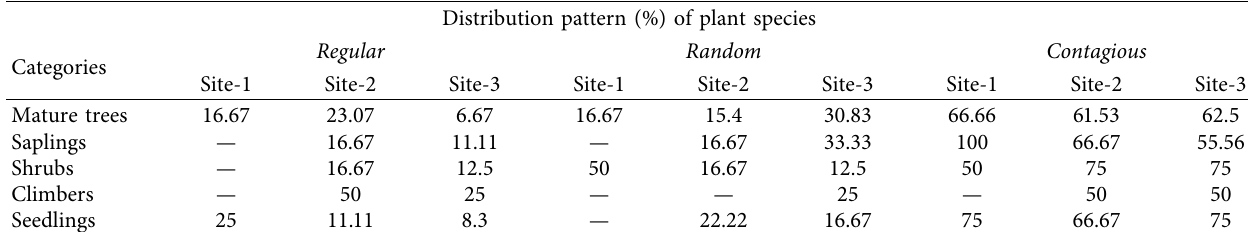
Table 8: Distribution pattern (%) of plant species in three distance sites of the Bhawal Sal forest.